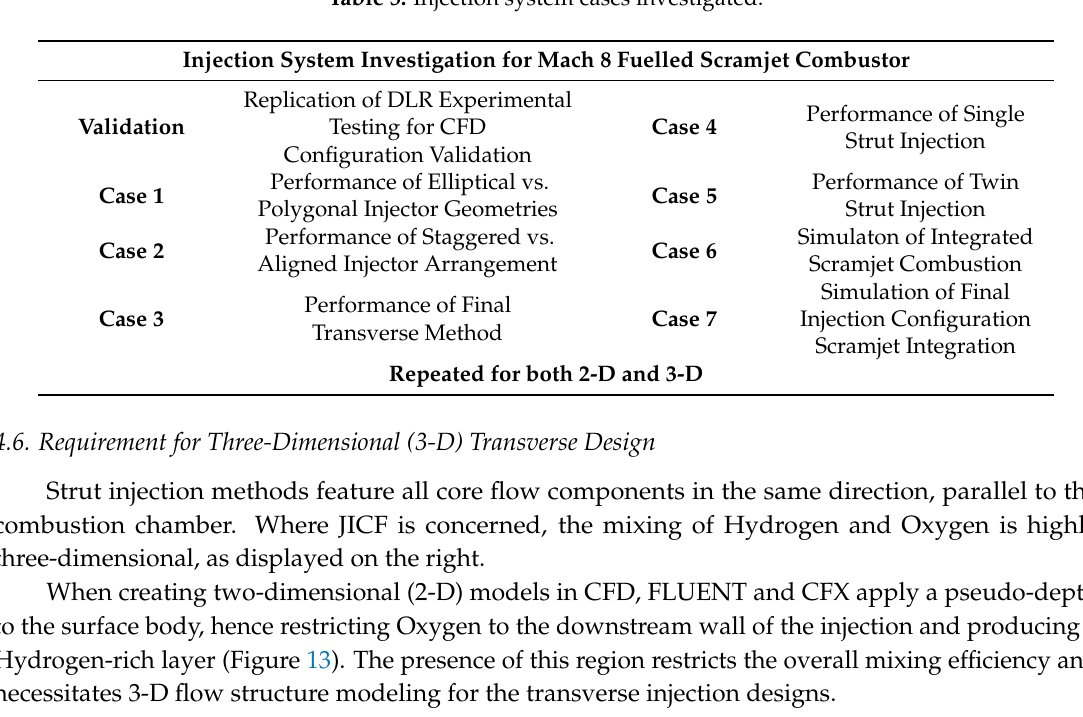
Table 5. Injection system cases investigated.